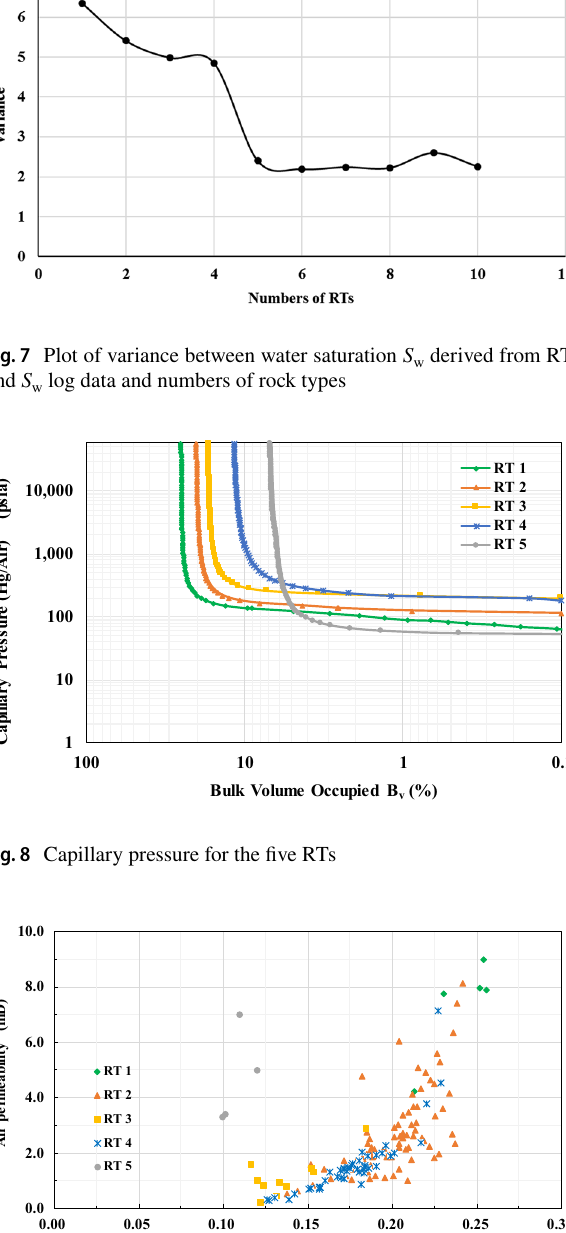
Fig. 9 Rock typing result illustration in porosity Φ versus permeabil- ity k air domain shows the petrophysical property difference of differ- ent rock